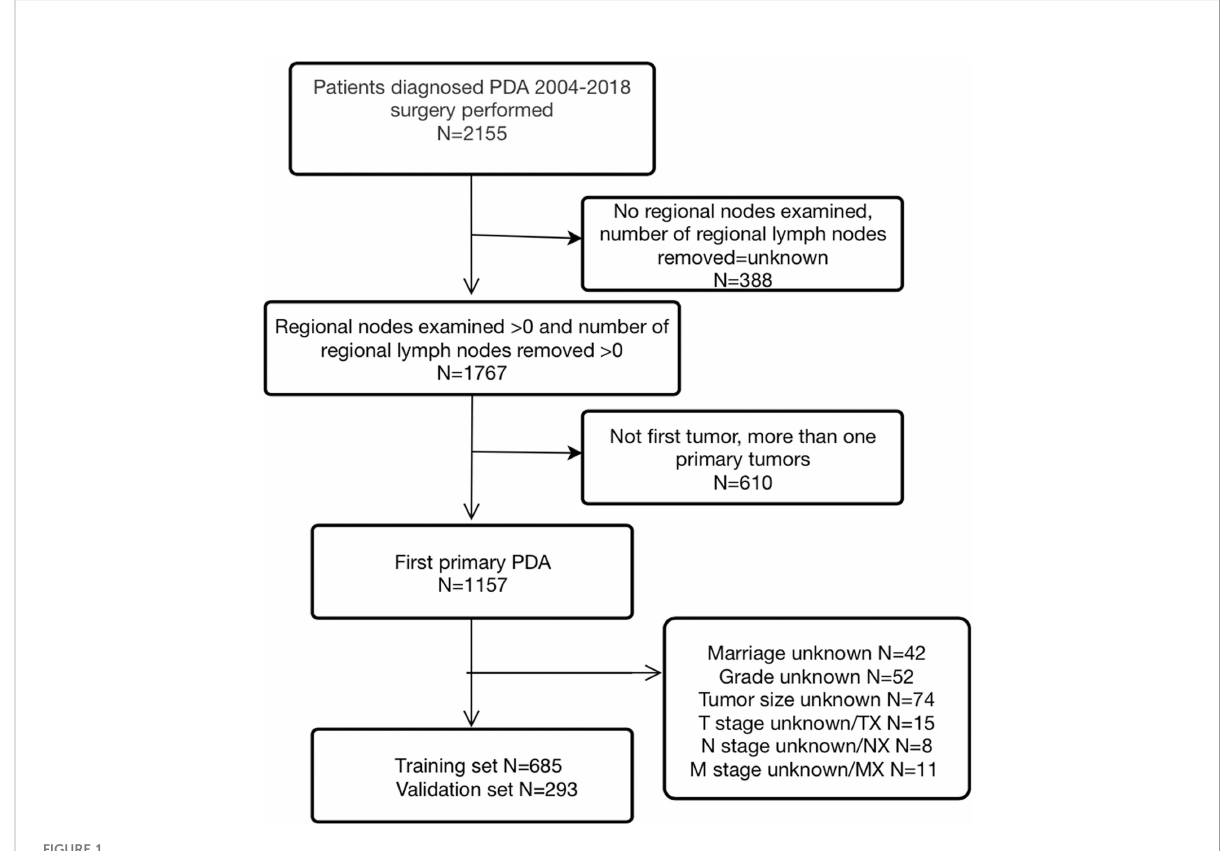
FIGURE 1 The fl ow chart of included patients.